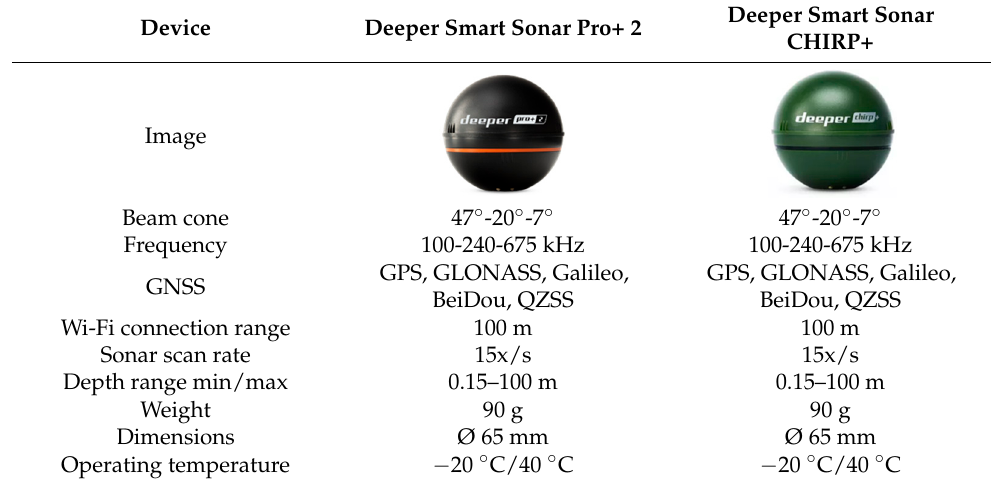
Table 1. Technical features of the Deeper Smart Sonar Pro+ 2 and the Deeper Smart Sonar CHIRP+.